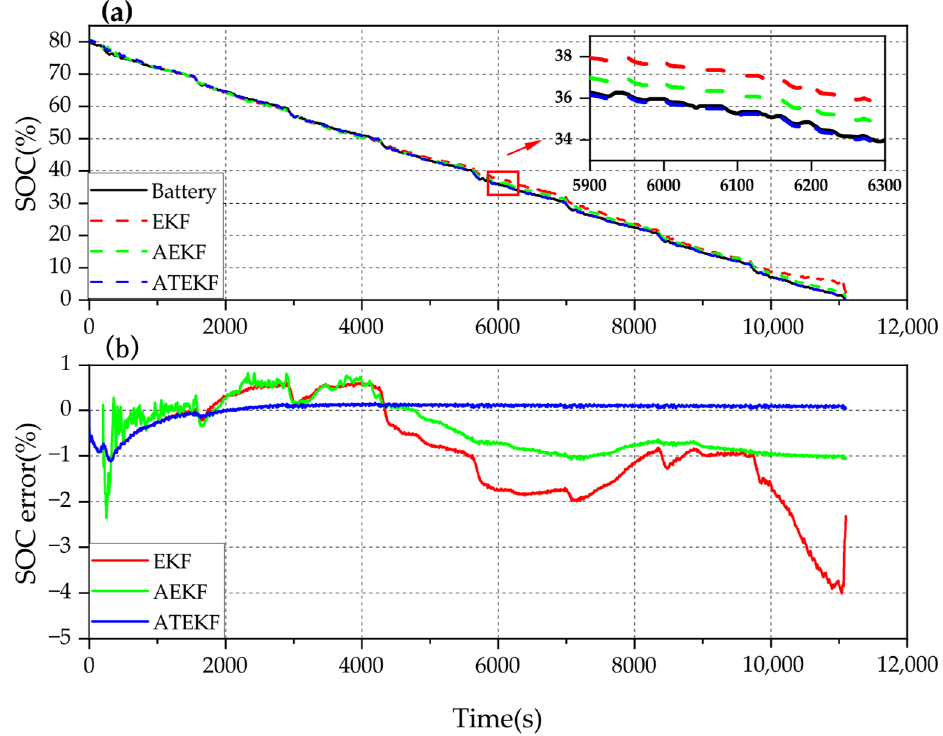
Figure 8. FUDS under 25 °C: ( a ) actual SOC, prediction of EKF, AEKF, and ATEKF; ( b ) SOC error comparison of EKF, AEKF, and ATEKF.